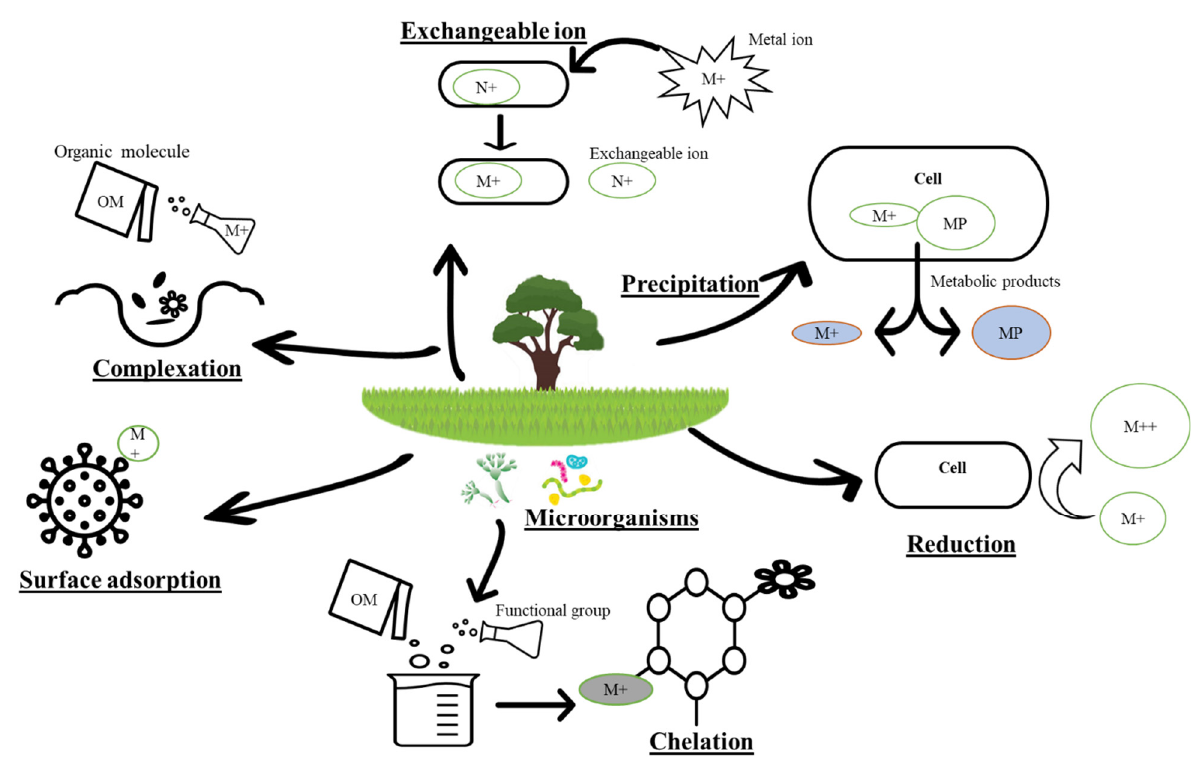
Figure 3. Possible heavy metal adsorption mechanisms.